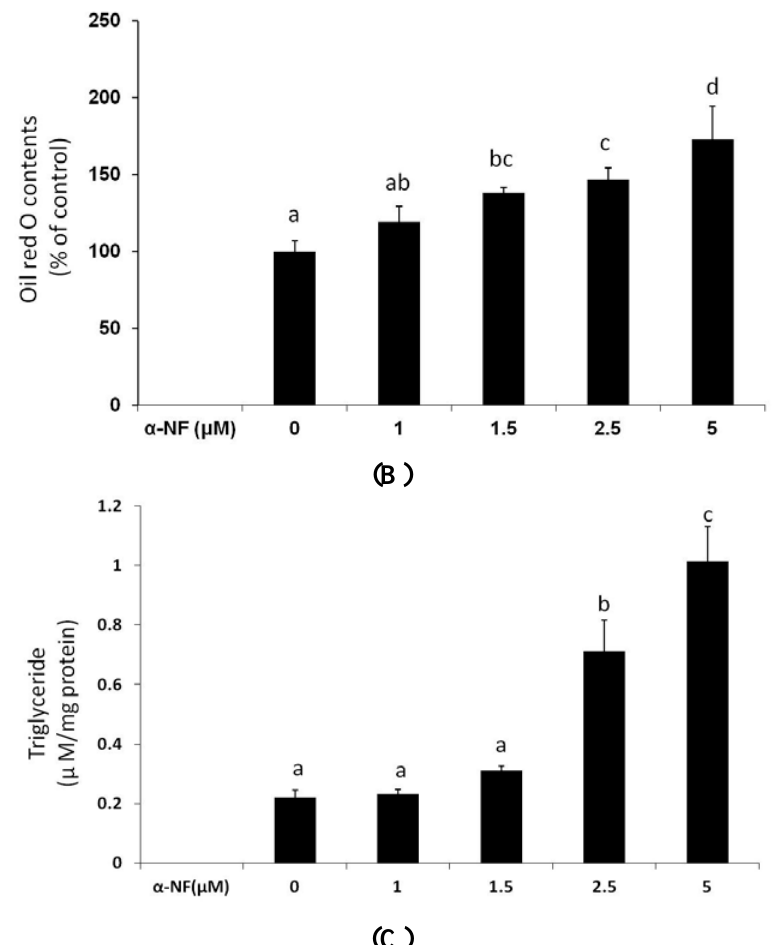
Figure 2. Effect of α-naphthoflavone (α-NF) on lipid accumulation in differentiated adipocytes. Cells were treated with various concentrations of α-NF for 16 h. Intracellular lipid accumulation was observed by oil-red-O staining (100× magnification) ( A ) and quantified ( B ) by the method described in “Materials and Methods”. Triglyceride (TG) contents ( C ) were quantified with a commercial kit. Pictures are representative of three independent experiments. Values are the mean ± SD from three measurements. Data with different letters significantly differ ( p <